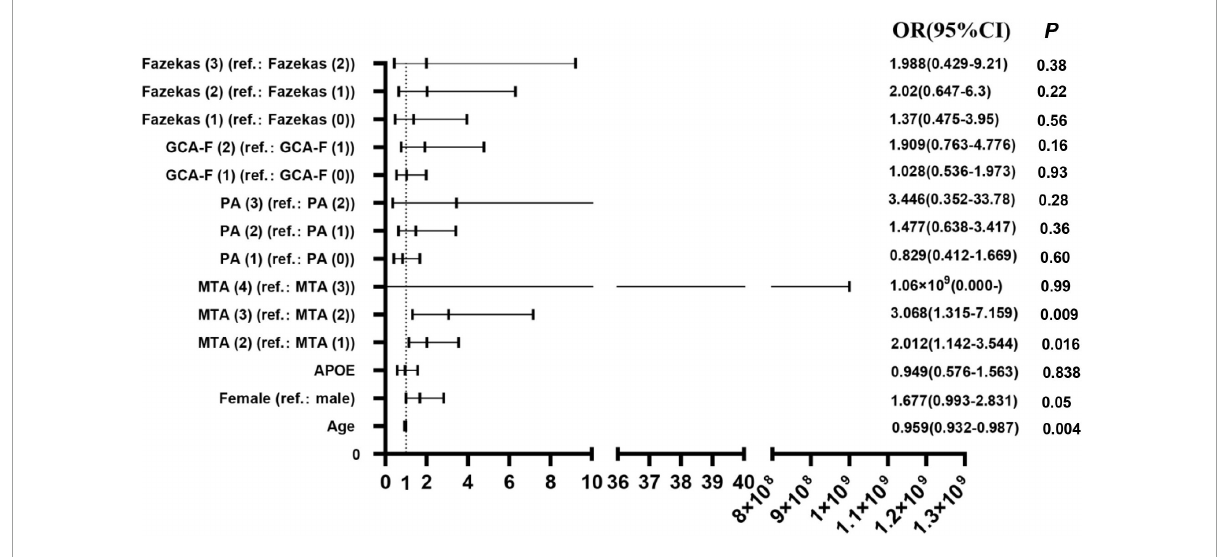
FIGURE1 Regression analyses of visual rating scales in the prediction of AD severity ( N = 435). OR, odds ratio; 95% CI, 95% confidence interval; B, regression coefficient. P < 0.05 was statistically significant.